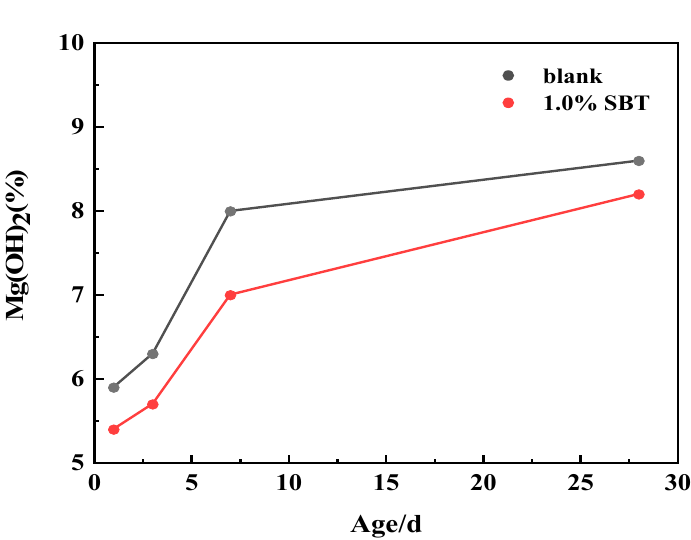
Figure 6. TG diagrams of cement slurry at 1 d, 3 d, 7 d and 28 d. ( a ) The TG curves of the blank group at 4 instars; ( b ) is the TG curve of 4 instars of hydration temperature rise inhibitor containing 1.0%SBT.